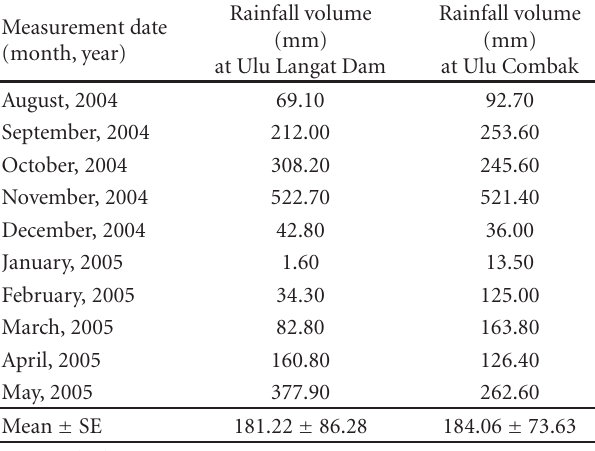
Table 2: Rainfall data at Ulu Langat Dam (near to Sungai Congkak) and Ulu Gombak (near to Sungai Batu) rainfall